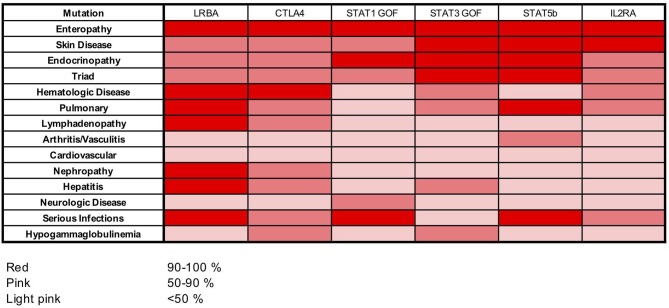
Heat map showing frequencies of clinical manifestations in our cohort of patients with LRBA, CTLA4, STAT1 GOF, STAT3 GOF, STAT5b, and IL2RA mutations.